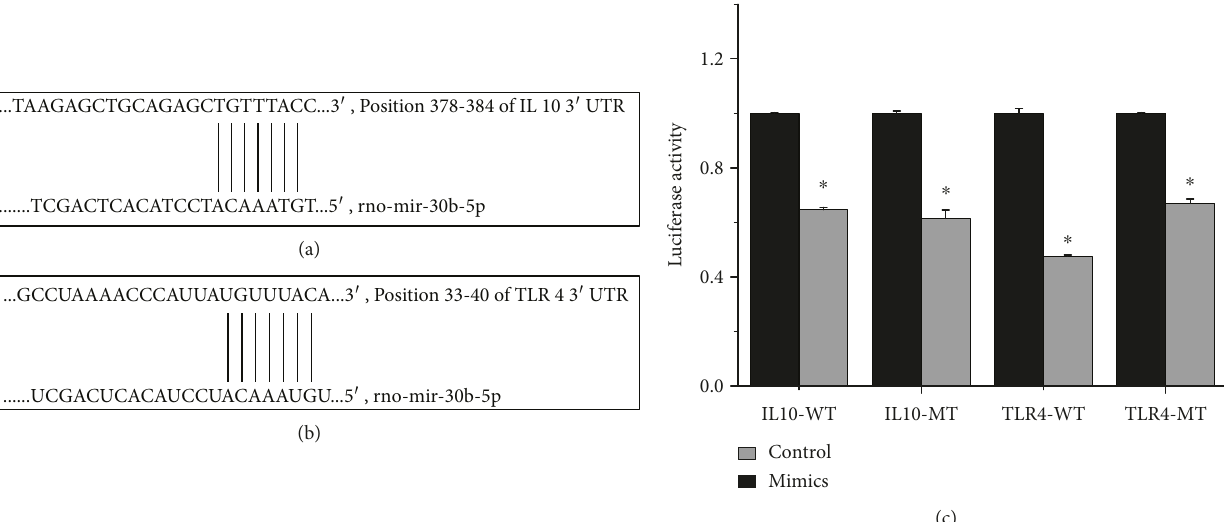
Figure 4: Validation of rno-miR-30b-5p targeted IL-10 and TLR4. Note: (a) sequence of 3 ’ UTR where IL-10 mRNA bound to rno-miR-30b- 5p; (b) sequence of 3 ’ UTR where TLR4 mRNA bound to rno-miR-30b-5p; (c) dual-luciferase reporter gene assay, which indicates that rno- miR-30b-5p mimic could inhibit the luciferases activity of rno-miR-30b-5p/IL-10-WT, IL-10-MT and TLR4-WT, TLR4-MT plasmid; ∗ P < 0 05 ; WT: wild type; MT: mutant